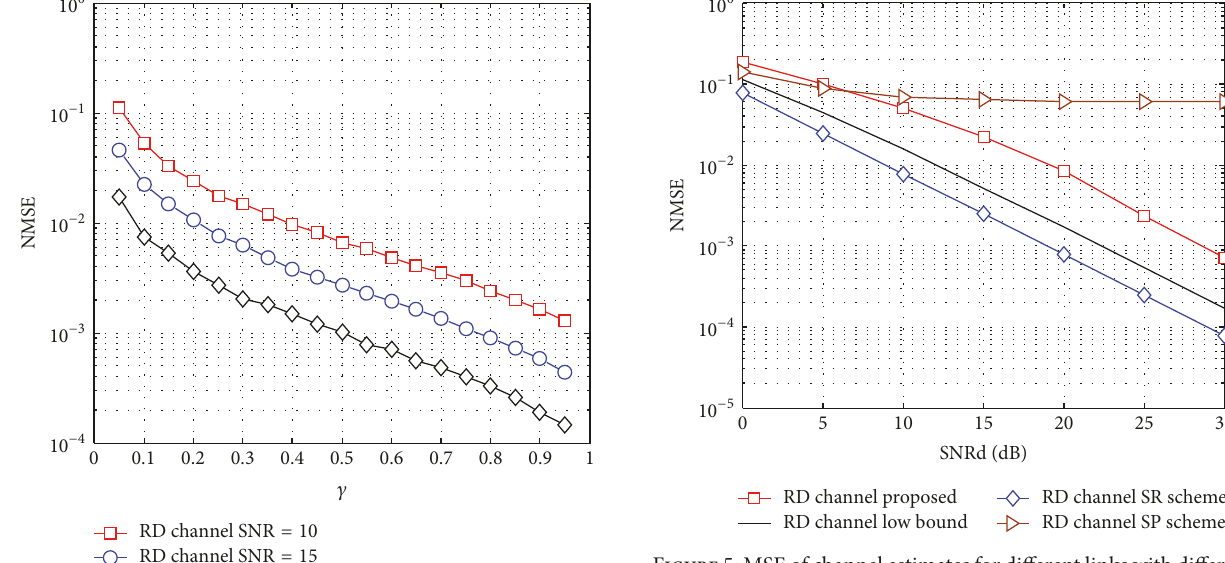
Figure 5: MSE of channel estimates for different links with different schemes.